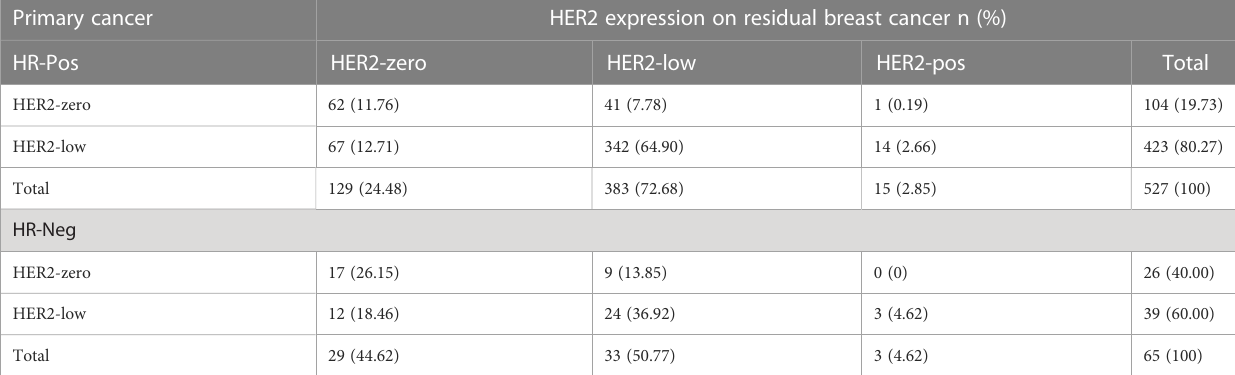
TABLE 4 HER2 expression evolution from primary breast cancer to residual according to tumor phenotype in the HER2-low cohort. Primary cancer